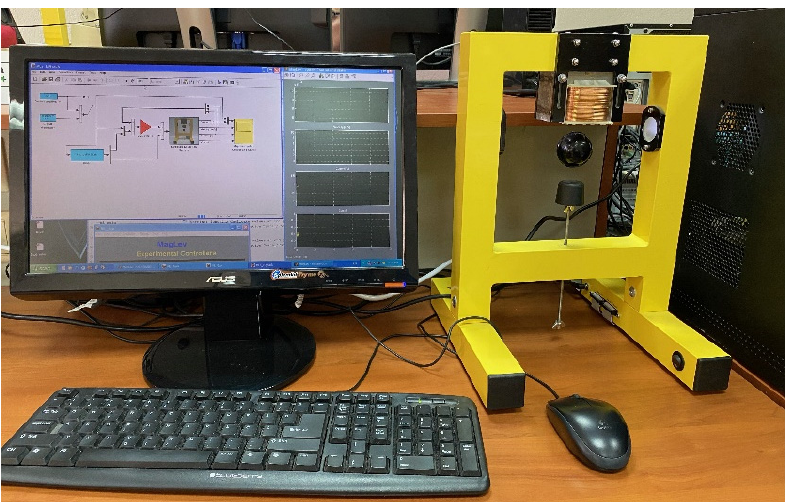
Figure 4. Laboratory system of MLS.